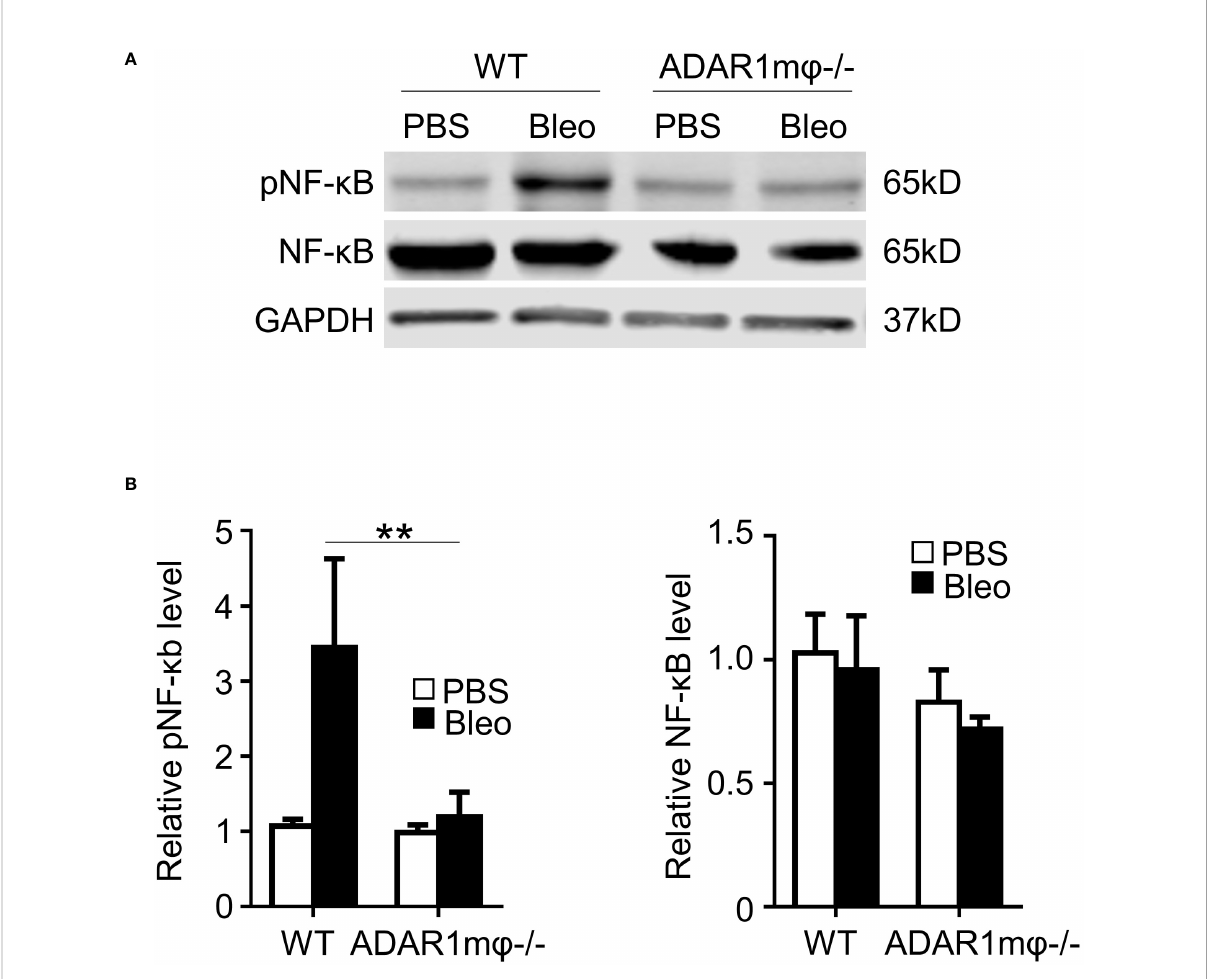
FIGURE 5 ADAR1 was essential for activation of the NF- k B pathway in M1 macrophages. (A, B) ADAR1 de fi ciency (ADAR1m j -/- ) signi fi cantly inhibited the bleomycin-induced NF- k B phosphorylation in skin tissues. WT and ADAR1m j -/- mice were injected s.c. with bleomycin (Bleo, 0.02U) and skin tissues were collected 1d after the treatment. Expression pNF- k B, and NF- k B in the skin tissues was measured by Western blotting (A) and quanti fi ed by normalizing to GAPDH (B) **P < 0.01 vs PBS-treated group in each panel, n = 3. 2-way ANOVA was used for comparison among